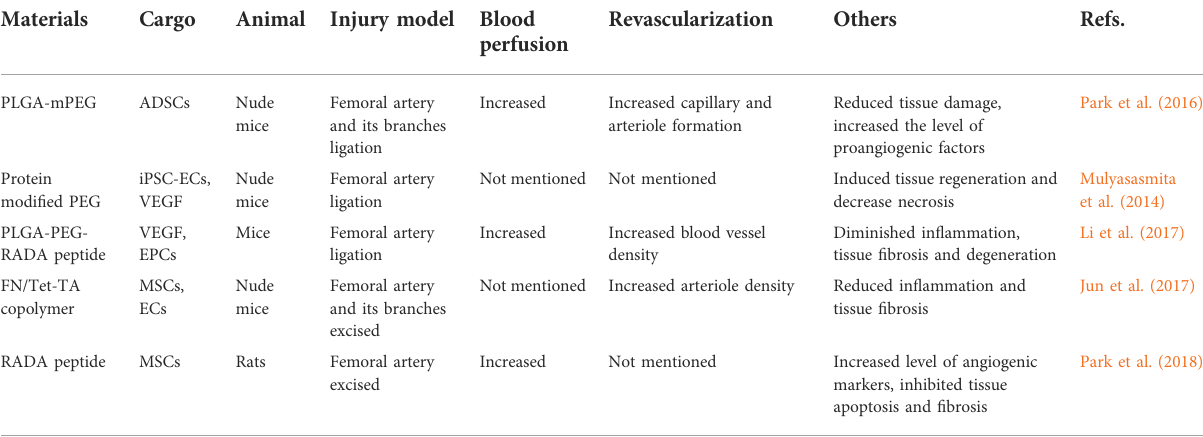
TABLE 3 Preclinical studies of synthetic hydrogels for LEAD.